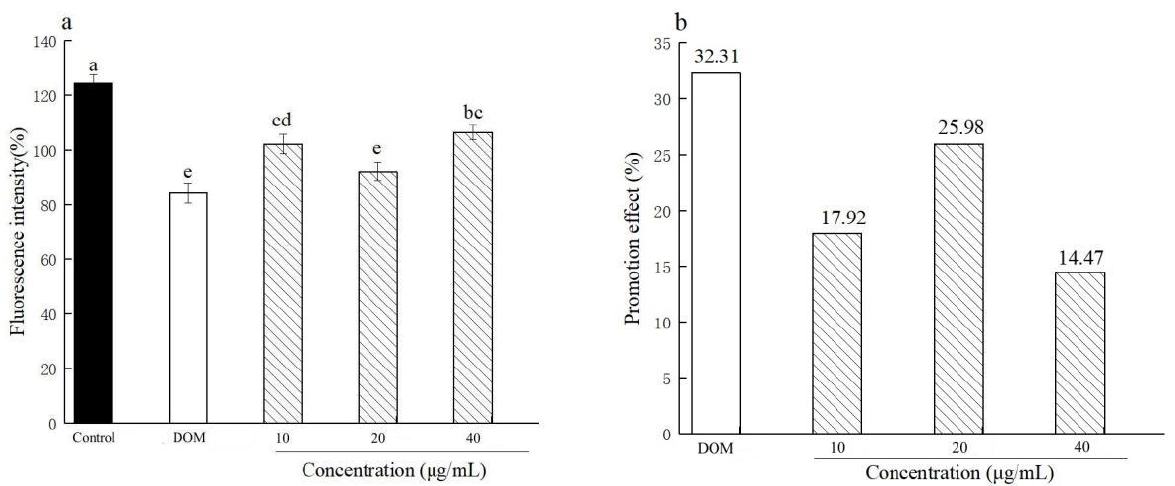
Figure 1. Effects of FWBP on intestinal peristalsis in zebrafish ( p < 0.05). ( a ) Fluorescence intensity, %; ( b ) Intestinal motility promotion effect, %. DOM: Domperidone. Different lowercase superscript letters denote statistically significant differences among different groups ( p < 0.05).